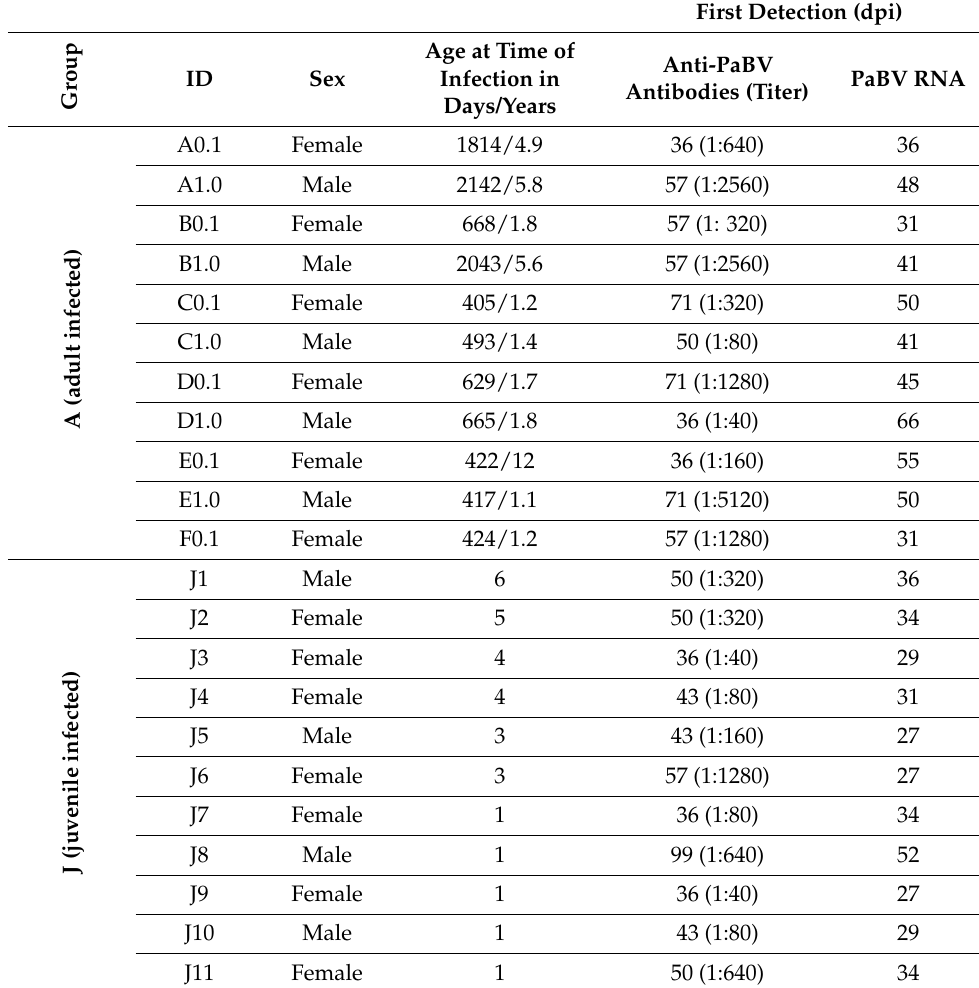
First Detection (dpi)